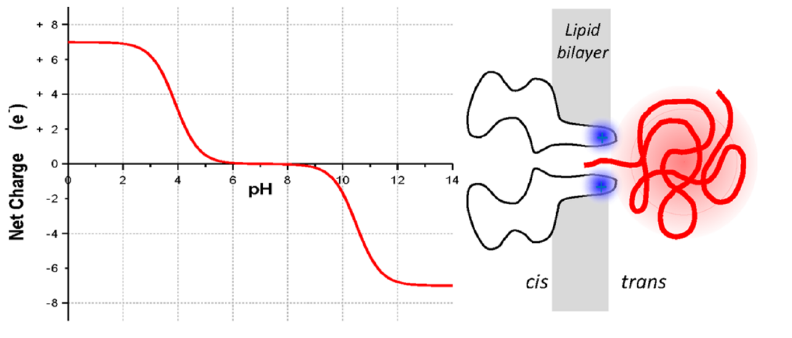
Figure 7. Results obtained by Jeon and Muthukumar [199] showing the net charge at the end of an α − hemolysine pore as a function of pH. Reprinted with permission from [199] copyright 2016 by American Chemical